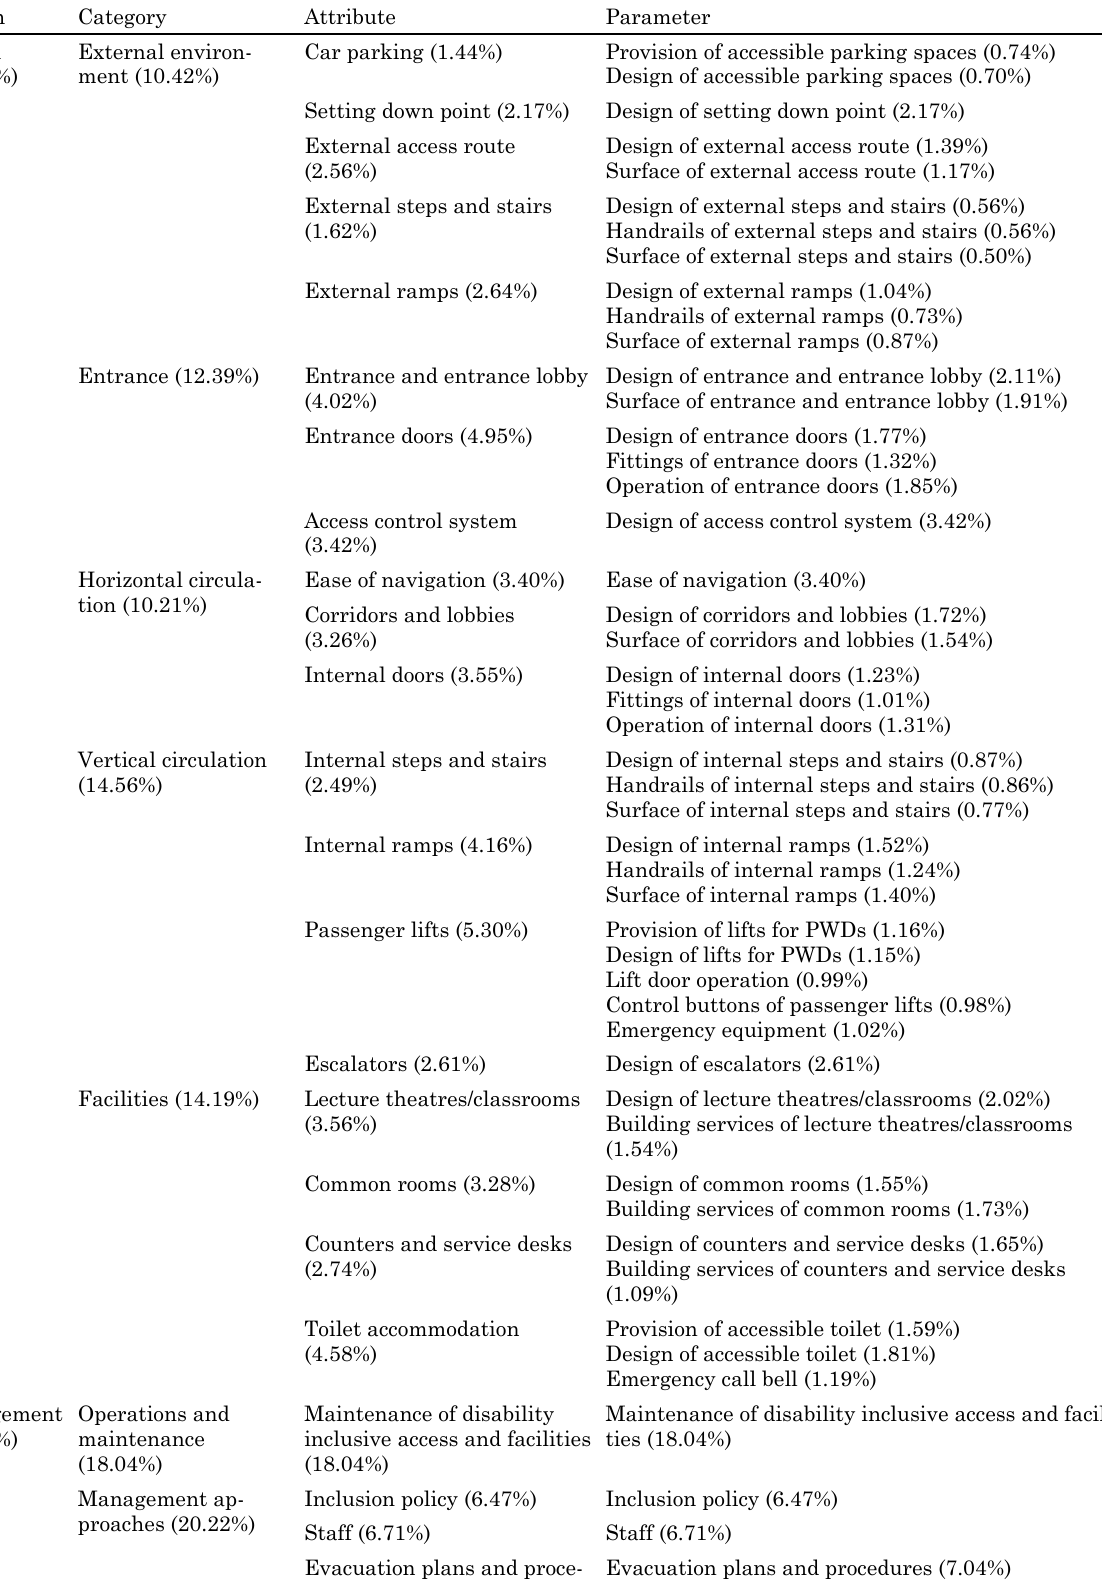
Table 1. Inclusion categories, attributes and parameters for the PDIS and